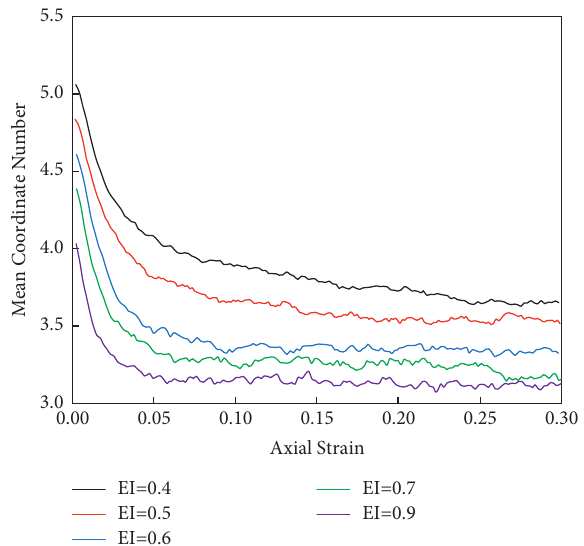
Figure 19: The evolution of mean coordination number versus axial strain.